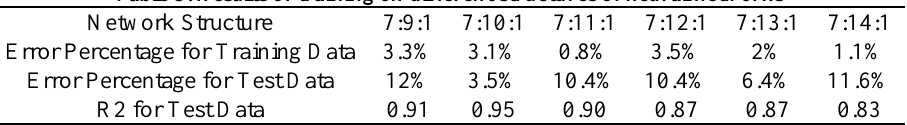
Table 3. Results of training on different structures of neural networks Network